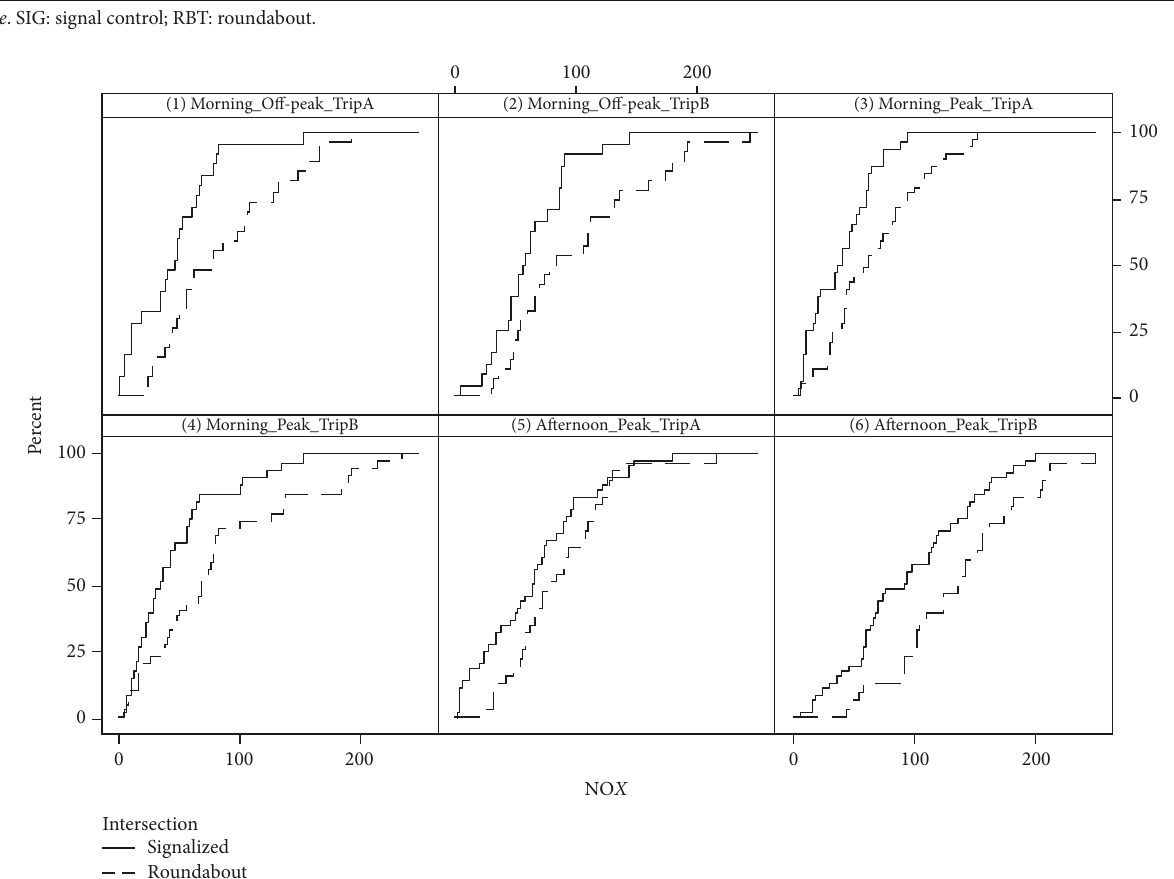
Figure 4: Empirical Cumulative Distribution Functions of NO 𝑋 emissions (mg) by intersection type and trip